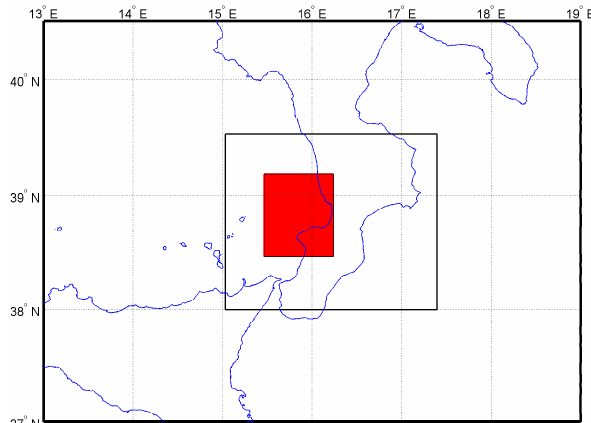
Fig. 13. Bathymetry and position of the buoy near Tropea.